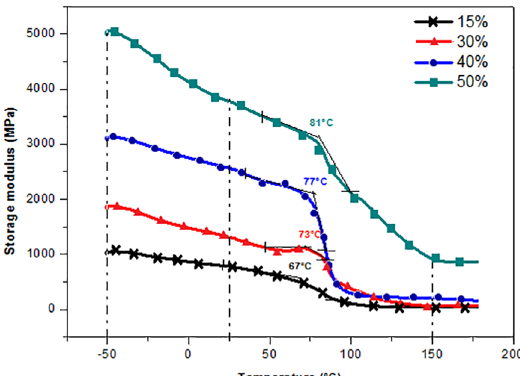
Figure 5. Variation of loss modulus, E”, as a function of temperature for the different fique fabric